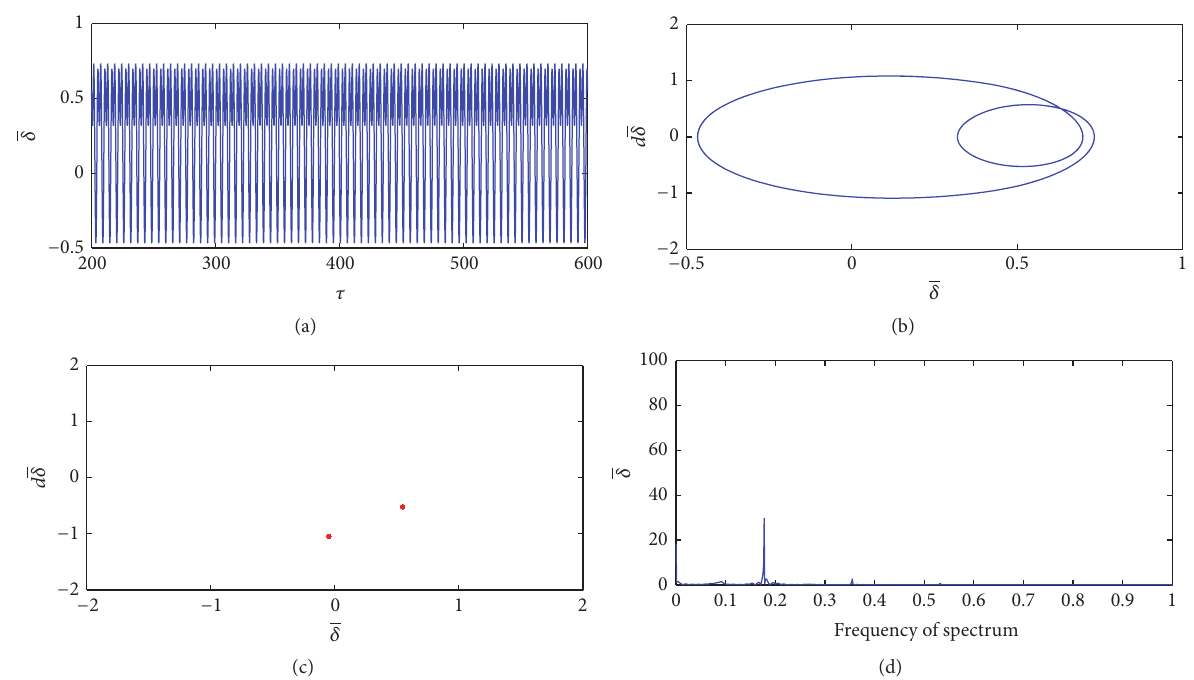
Figure 13: 𝑏 = 40 𝜇 m: (a) time history; (b) phase plane; (c) Poincar´e map; (d) Fourier